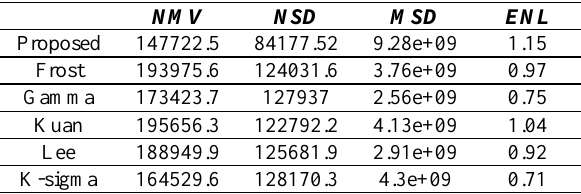
Table. 1: Speckle noise reduction results of ENVISAT